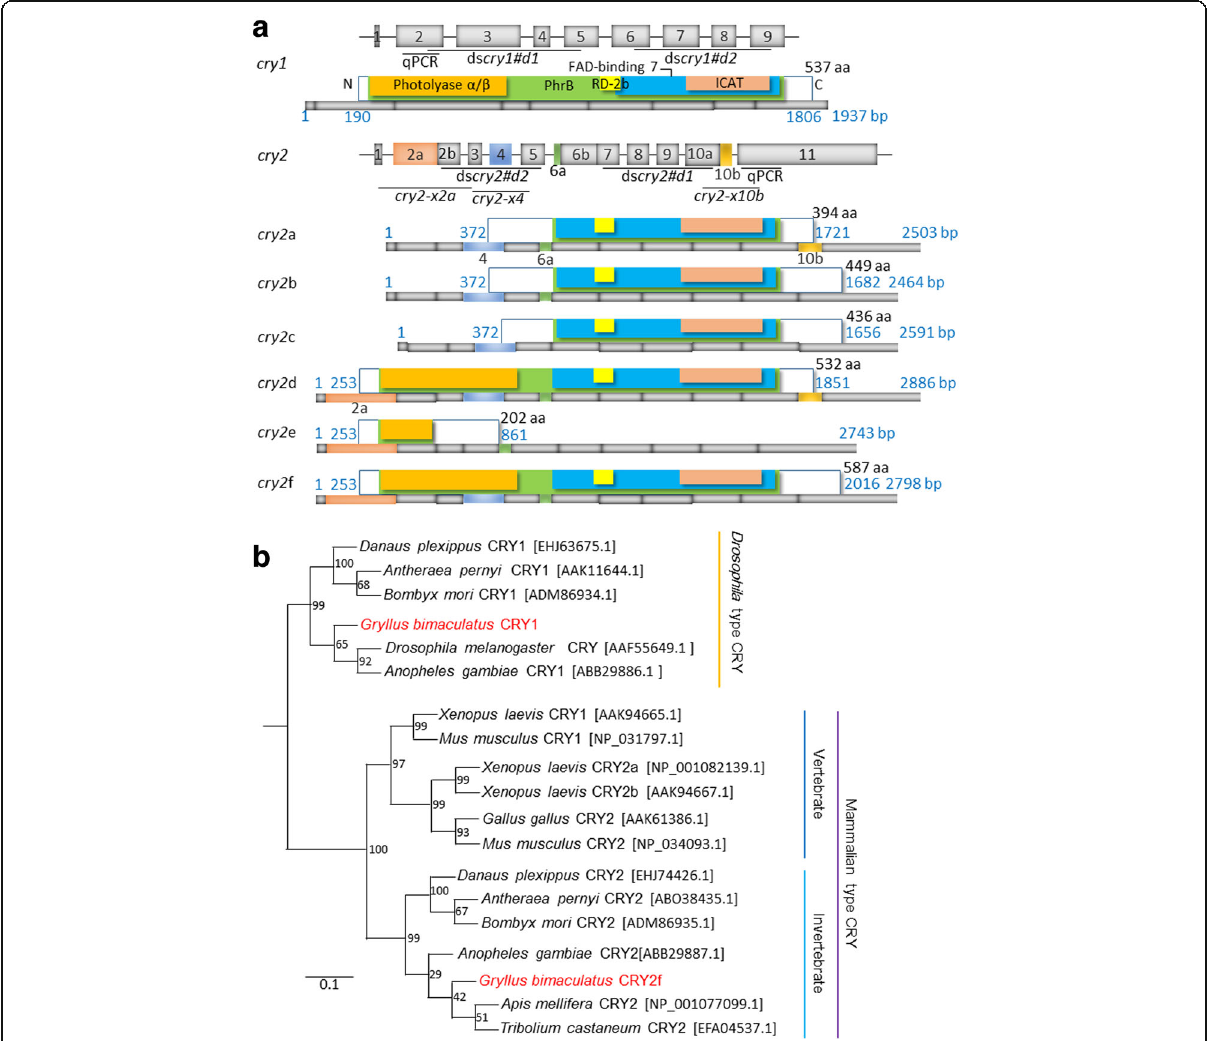
Fig. 1 Sequence alignments and a phylogenetic tree of Gb ’ cry1 and Gb ’ cry2 . a Schematic structure of Gb ’ cry1 and Gb ’ cry2 cDNAs and their deduced product proteins, showing conserved domains, photolyase α / β ( orange ), PhrB ( green ), RD-2b ( yellow ), FAD-binding 7 ( blue ), and inhibition of CLOCK-ARNTL-mediated transcription (ICAT) domain ( pink ). At the top of schemes of each gene exon/intron structure is illustrated. There are six splicing variants for Gb ’ CRY2, of various lengths. The bars under each protein scheme show cDNA structure and the colored portions indicate the respective exons. Numbers shown at the right of protein illustration indicate the number of amino acid residues (aa) and the blue numbers indicate the number of base pairs. The regions used for qPCR and dsRNA synthesis are also shown. cry2-x2a , - x4 , and – x10b are for PCR for amplification of variants with or without exon 2a, 4, and 10b, respectively. b A phylogenetic tree of known insect and vertebrate CRY proteins. CRY amino acid sequences were analyzed, and the phylogenetic tree was inferred by the maximum likelihood method in MEGA 7.0. The GenBank or RefSeq accession numbers are indicated in brackets. The reference bar indicates the distance as number of amino acid substitutions per